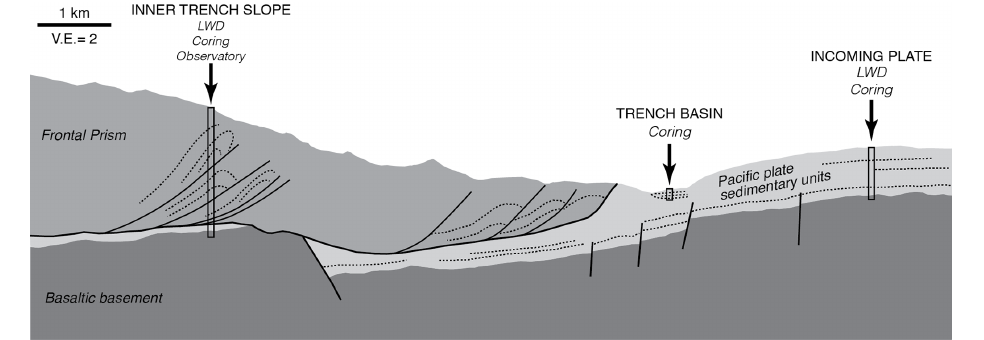
Figure 2. Schematic section through the frontal prism, trench and incoming section showing the framework for the two proposed trench normal transects, locations of the holes and list of target data for each hole (dashed lines represent possible bedding attitudes; solid lines are possible faults; structure based on Nakamura et al.,